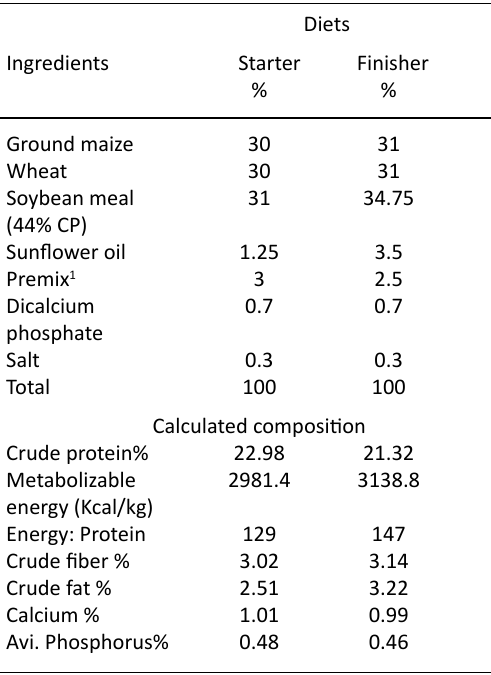
Table 1. Gross composition and calculated analyses of the experimental